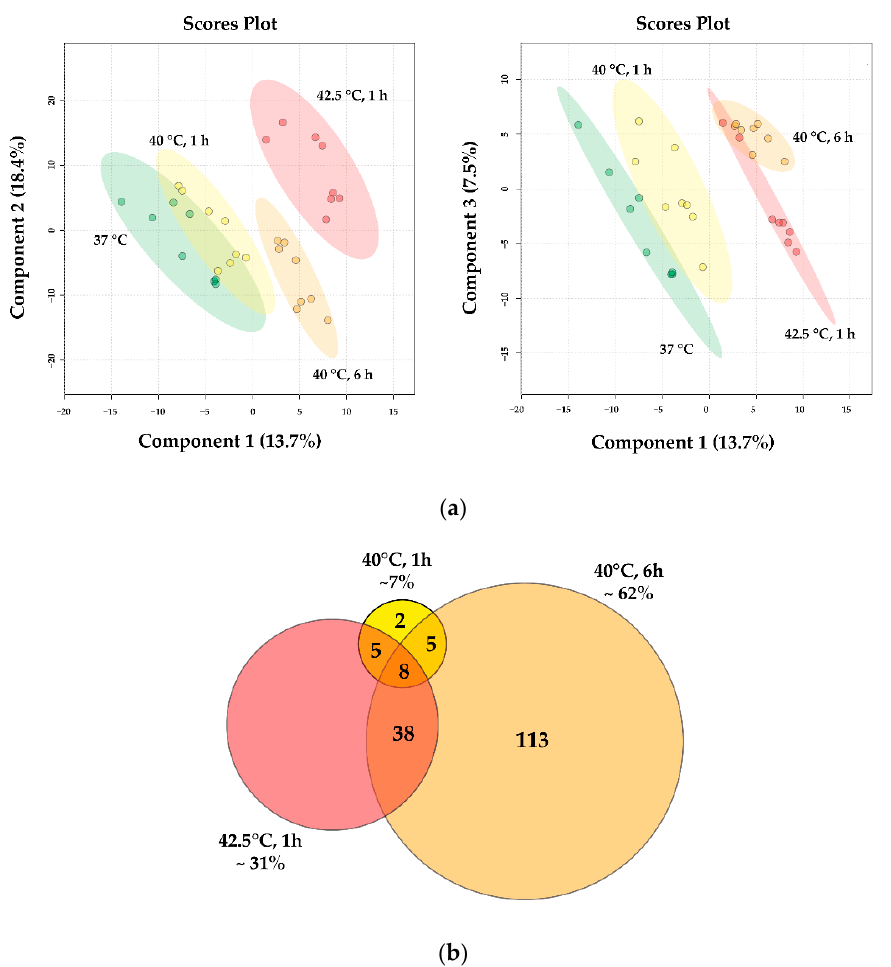
Figure 6. Heat-induced lipidomic changes. CHO cells were left untreated or subjected to 40 °C for 1 or 6 h or 42.5 °C for 1 h. ( a ) Partial least squares discriminant analysis score plots of lipidomic dataset based on relative concentration values. Circles display 95% confidence regions. The model was val- idated by a 2000-time permutation test ( p = 0.0015). ( b ) Venn diagram displaying the number of statistically different components. Table 2. Selected, significantly changing membrane lipid species.